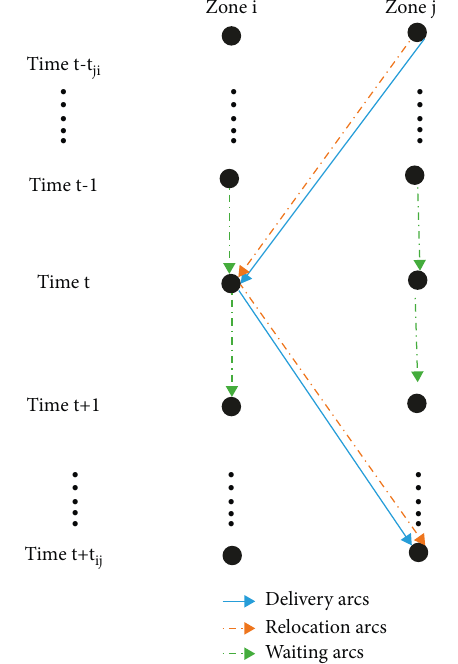
Figure 3: SAV flow conservation in time-space